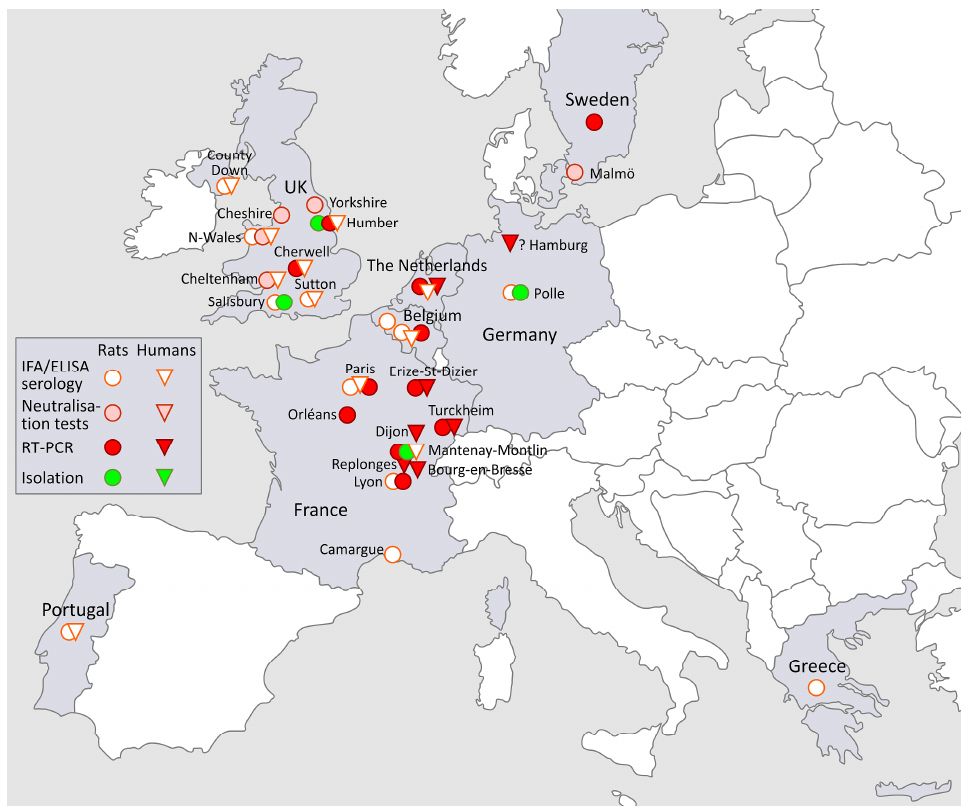
Figure 2. The map does not aspire to completeness and refers only to data given in the text. Except for IR461, isolated in 1984 in Porton Down, Salisbury, UK [90], and for the Polle 18 SEOV strain, isolated in 1988 in Germany (Lower Saxony) [91], all other European SEOV isolates are of more recent dates (see text). The first (1978) western human SEOV infections, propagated by laboratory rats, were clinically described in Belgium [92,93], whereas the earliest series of 16 clinically and serologically proven SEOV-HFRS cases, after exposure to wild rats, was documented in County Down, Northern Ireland, UK, 1994 [94]. For the 1983 and 1988 probable isolated SEOV-HFRS cases in Glasgow and elsewhere in the UK, see the Supplementary Table S1 in the review by McElhinney et al.